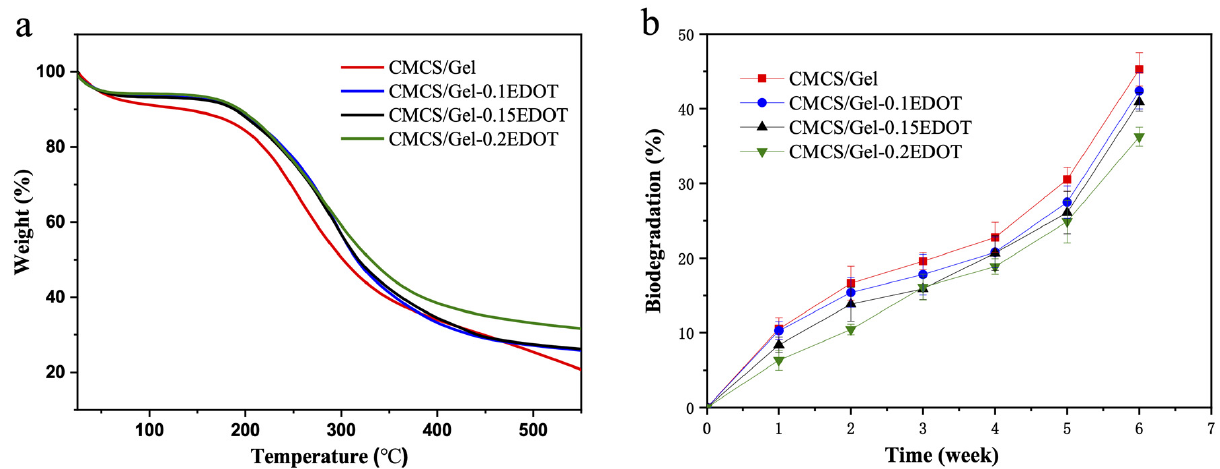
Figure 5. TGA curves ( a ) and biodegradation ( b ) of CMCS/Gel and CMCS/Gel-PEDOT hydrogels.